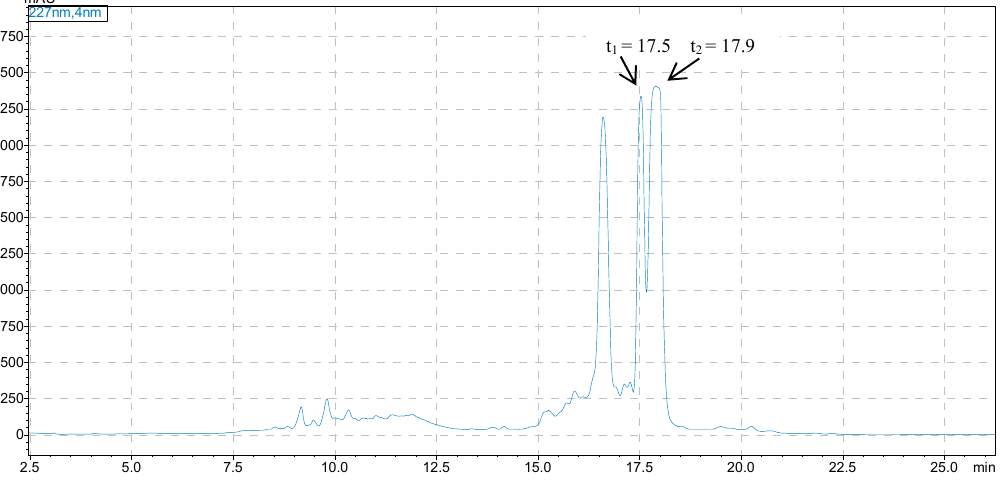
Figure 1. HPLC chromatogram of the crude extract of C. chinensis after enrichment by multistep column chromatography (MCC).